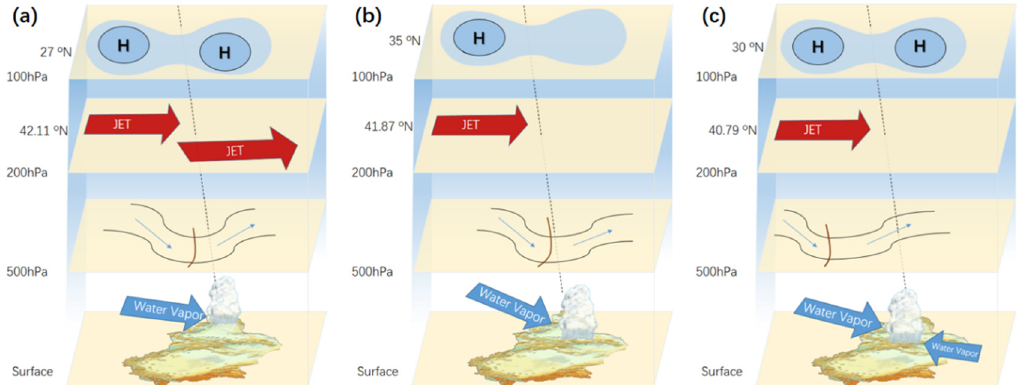
Figure 13. Conceptual model of ( a ) Type NN, ( b ) Type EN and ( c ) Type CT. “H” represents the center of the high pressure. The black line represents the isobaric line. The brown line represents the trough line. The narrow blue arrow represents air flow. The latitudes on the left indicate the averaged location of the system on that level. The dotted black line represents the location of rainfall on the different levels.